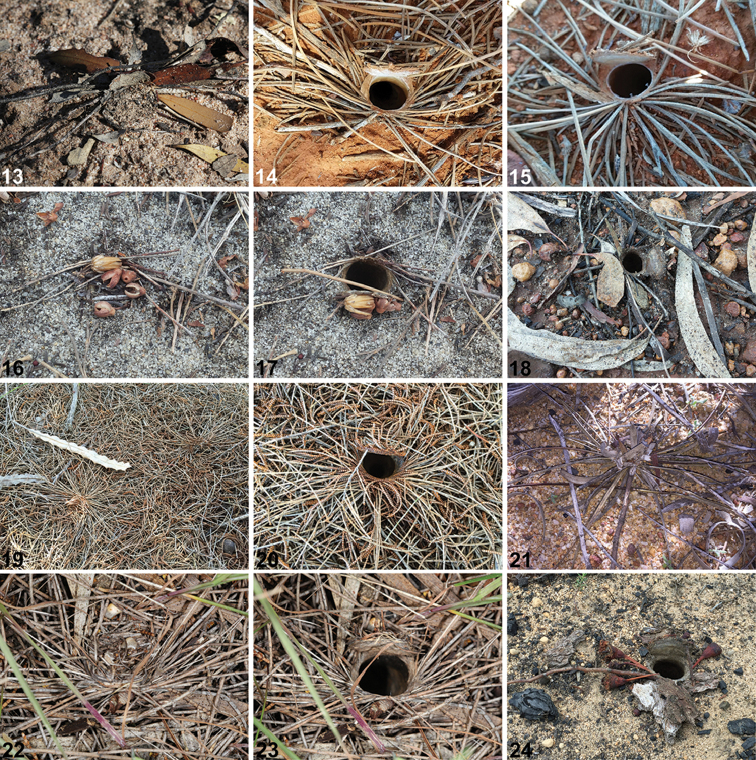
Burrows of shield-backed trapdoor spiders of the Idiosoma
nigrum-group. 13
I.
nigrum from Minnivale Nature Reserve (Western Australia) 14–15
I.
clypeatum sp. n. from Weld Range (Western Australia) 16–17
I.
sigillatum (O. P.-Cambridge, 1870) from Shenton Park, Perth (Western Australia) 18
I.
schoknechtorum sp. n. from Meenaar Nature Reserve (Western Australia) 19–20
I.
arenaceum sp. n. from Kalbarri National Park (Western Australia) 21
I.
kopejtkaorum sp. n. from Charles Darwin Nature Reserve (Western Australia) 22–23
I.
jarrah sp. n. from N. of Arthur River (Western Australia) 24
I.
mcclementsorum sp. n. from Julimar State Forest (Western Australia). Note the ‘moustache-like’ arrangement of twig-lines characteristic of the nigrum-group. Images 13, 19–23, 24 by M. Harvey; 14–15 by Astrid Heidrich, used with permission; 16–18 by M. Rix.